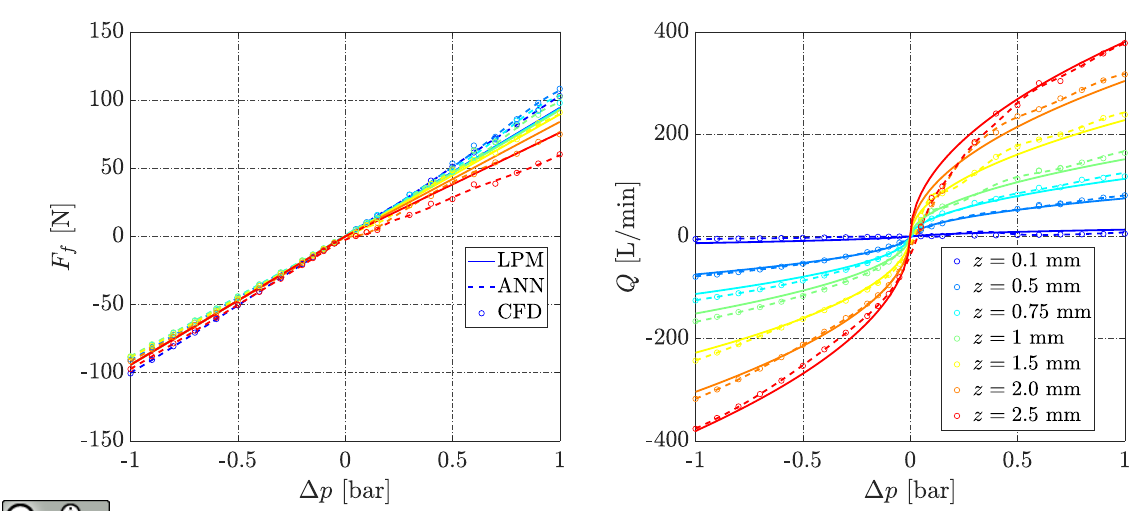
Figure 17: Same as in Figure 15 but with R = 20 mm & w = 7 . 5